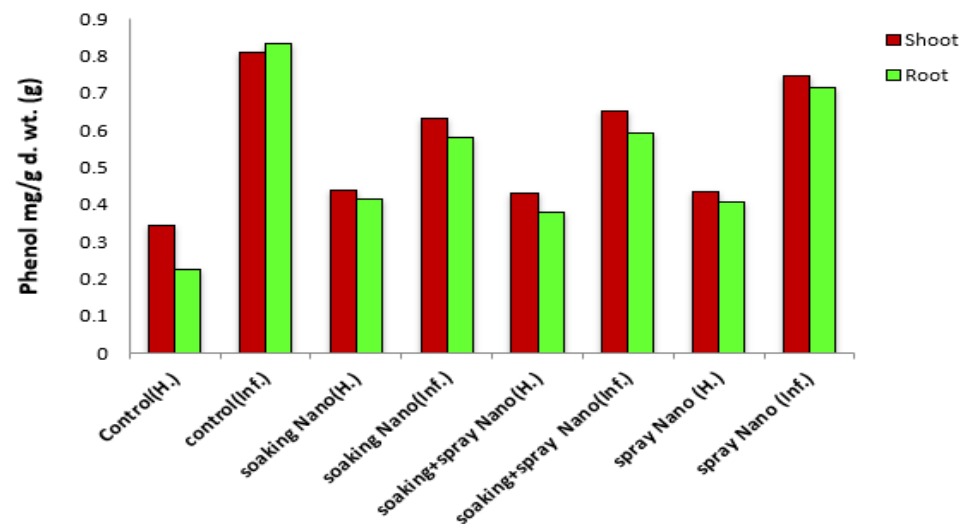
Figure 6. Effect of Se-NPs on the phenolics compounds of ( Vicia faba L.). Effect of Se-NPs on a Total Soluble Protein of Vicia faba under Pot Conditions were significantly decreased in cv. Giza 716 plants in response to the infection with R.